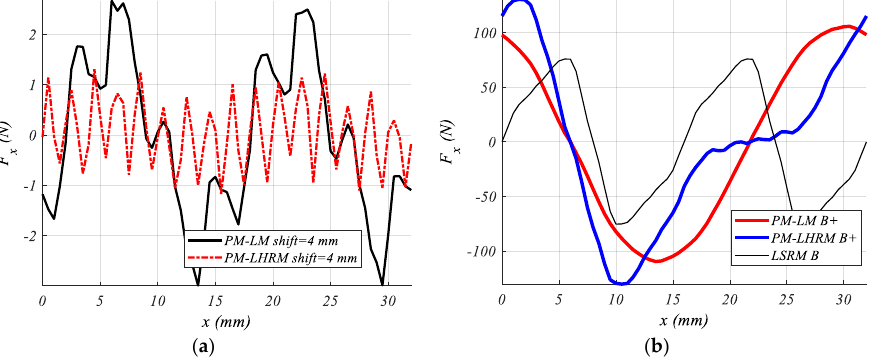
Figure 9. ( a ) Detent force comparison results at s = 4 mm. ( b ) Phase force comparison results for a current density of 10 A/mm 2 and shift = 4 mm.